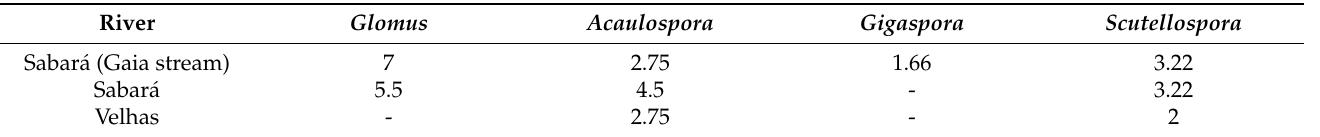
Table 3. Arbuscular mycorrhizal spore number/100 g soil dry weight in three riparian sites studied at Velhas River and its tributaries (dry season).